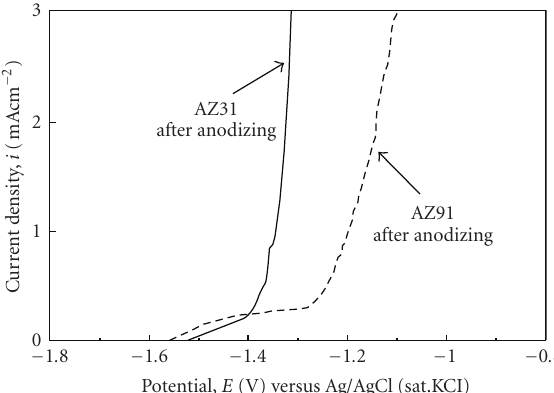
Figure 10: Anodic polarization curves of anodized AZ31 and AZ91 magnesium alloys in 17 mMNaCl and 0.1 MNa 2 SO 4